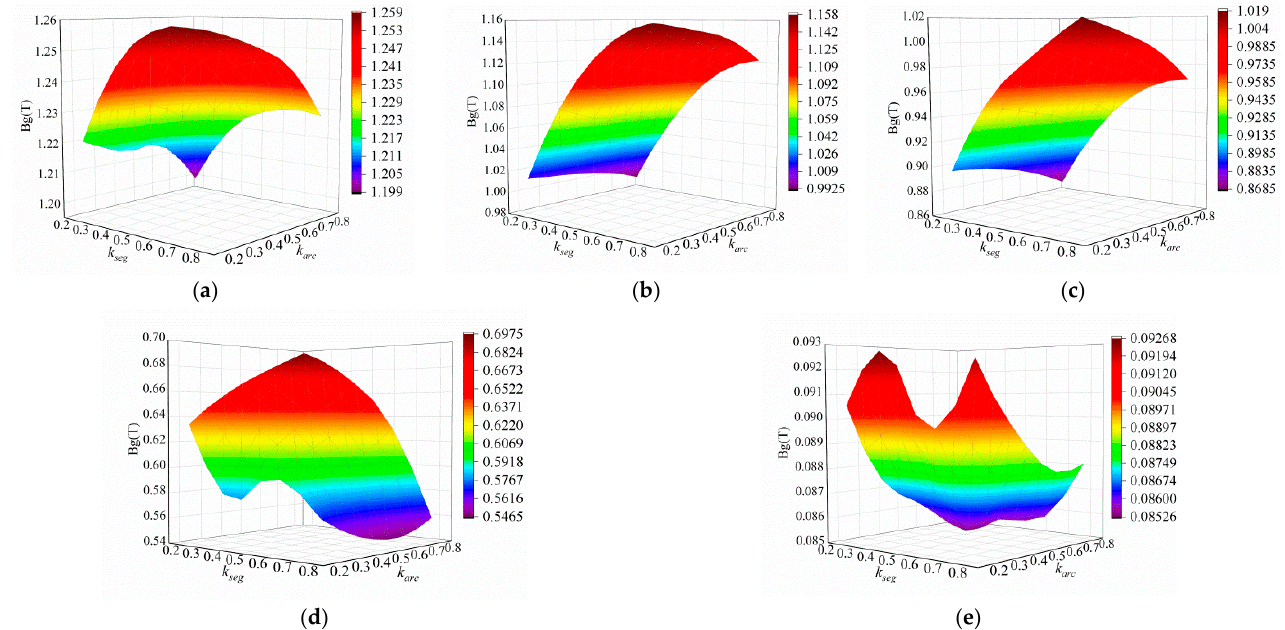
Figure 8. The influence of cross-shaped flux-barriers parameters on flux density in each region of air-gap: ( a ) region B1; ( b ) region B2; ( c ) region B3; ( d ) region B4; ( e ) region B5.